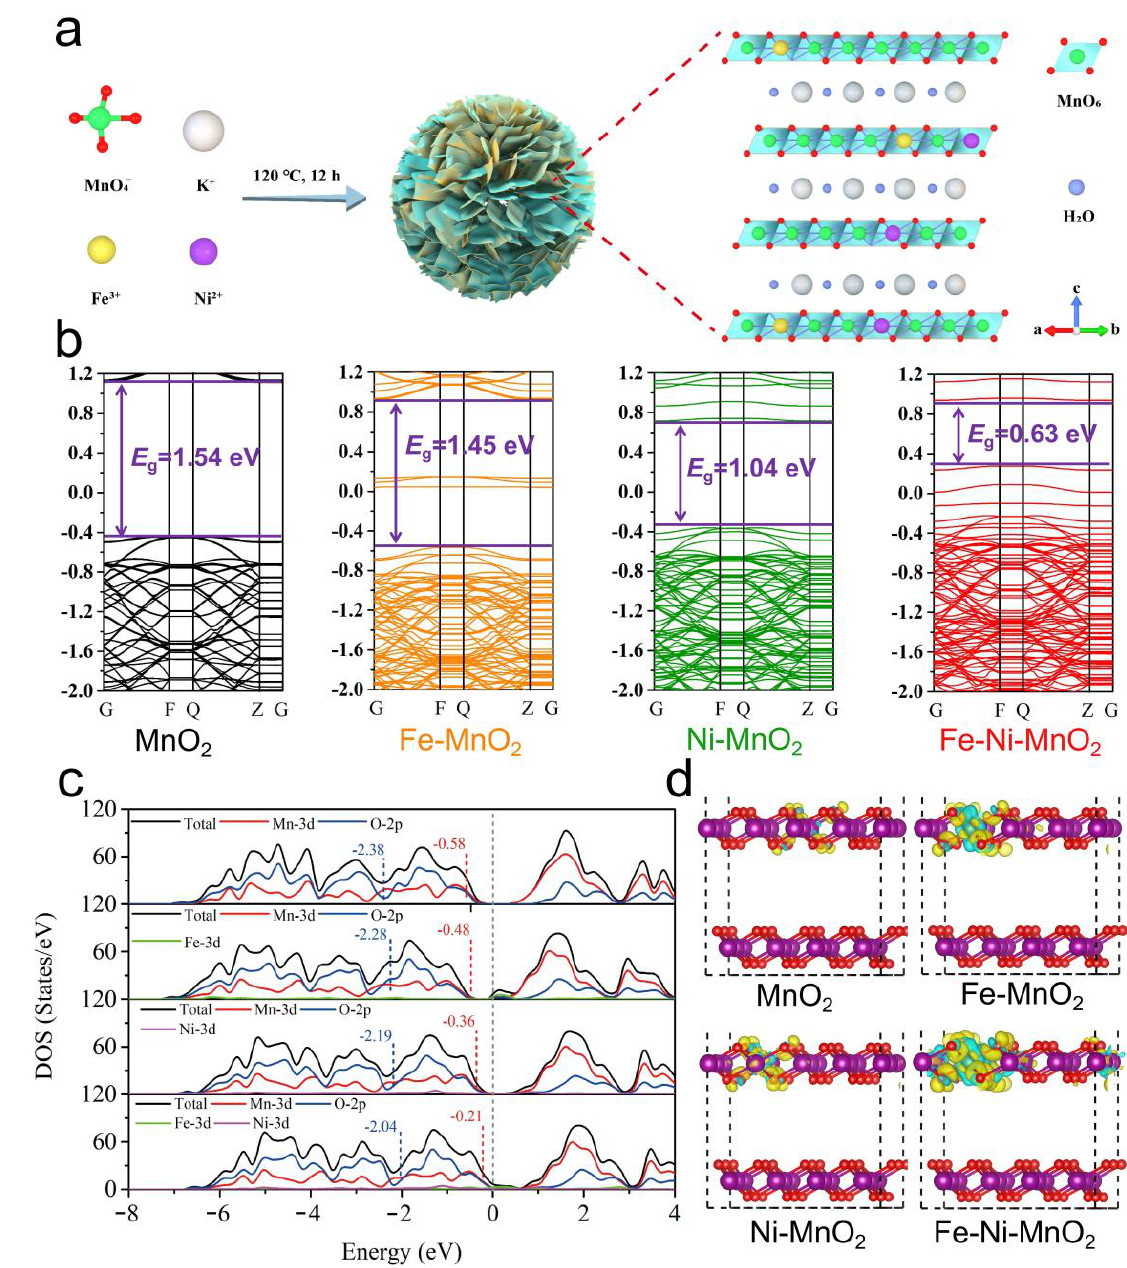
Figure 1. ( a ) Synthesis schematic of NFMO, ( b ) band structures, ( c ) PDOS and ( d ) charge density of the four theoretical calculation structural models (MO, FMO, NMO and NFMO, red represents oxygen, purple represents manganese, yellow represents iron, and silver represents nickel).